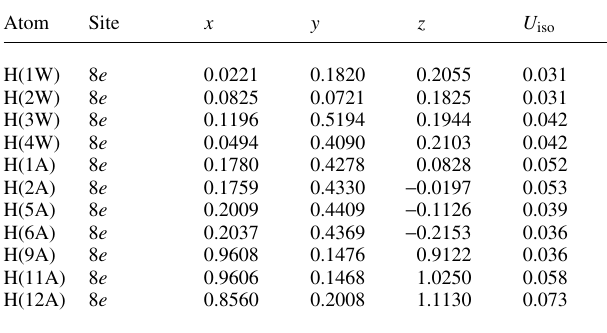
Table 2. Atomic coordinates and displacement parameters (in Å 2 )